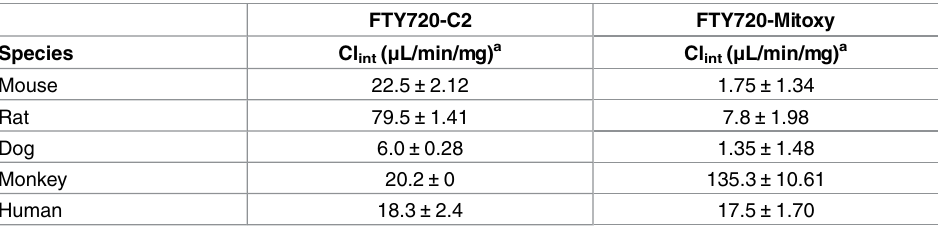
Table 3. IntrinsicClearancein Liver